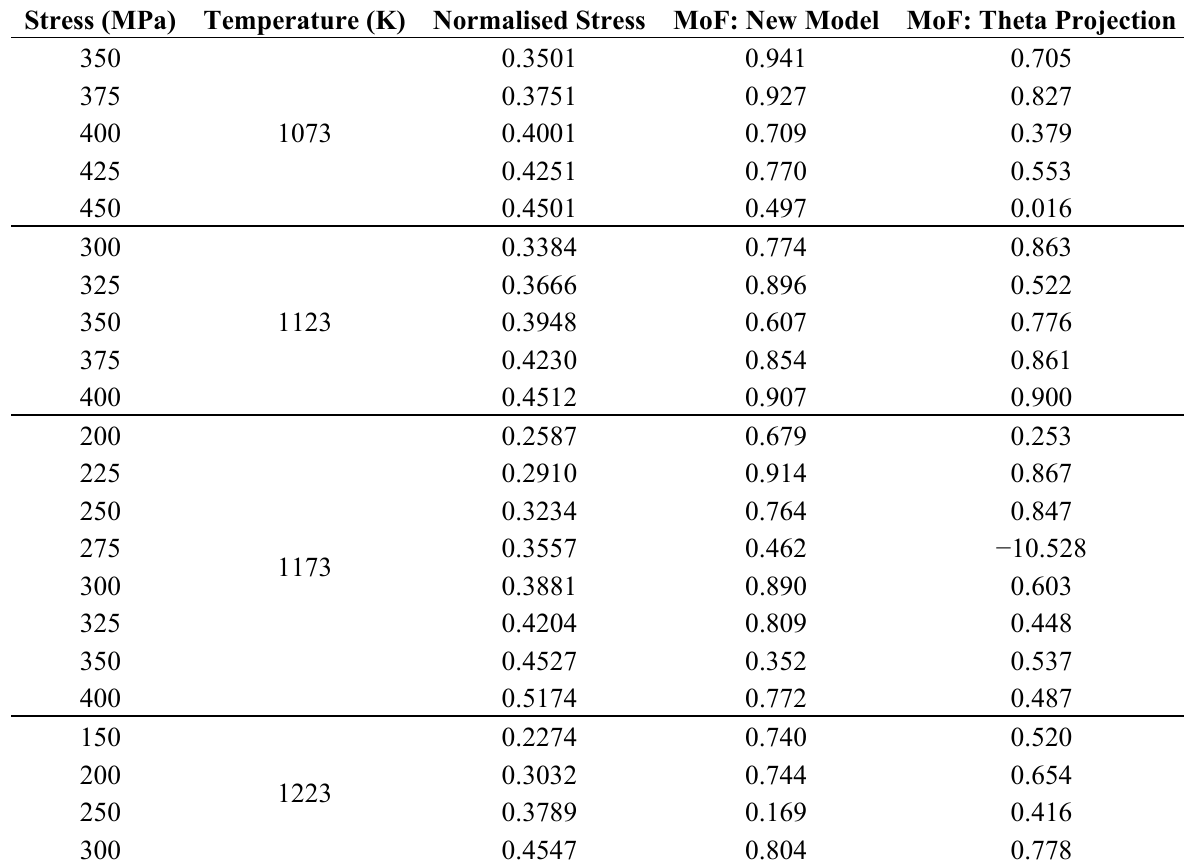
Table 1. IN100 MoF for new model and theta projection. Failures highlighted in grey text (MOF <